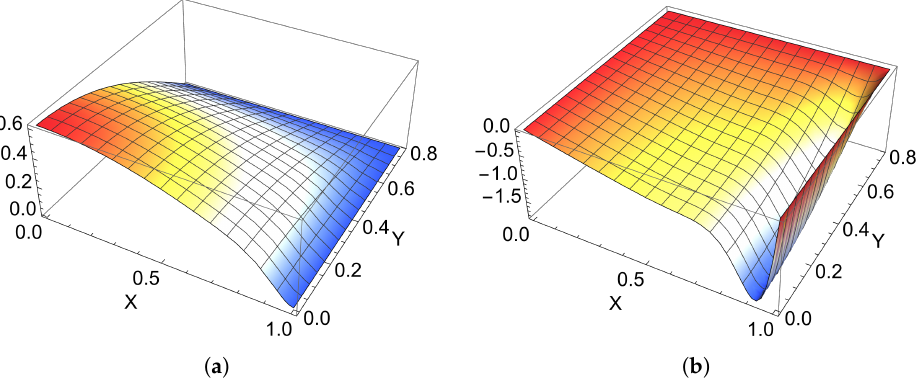
Figure 9. Pitkäranta cylinder: clamped case. Detail of the domain with symmetry/antisymmetry boundary conditions applied. The boundary layer in the rotation component with the characteristic √ t = 1/10 is clearly visible. ( a ) Transverse deflection. ( b ) Rotation θ length scale of